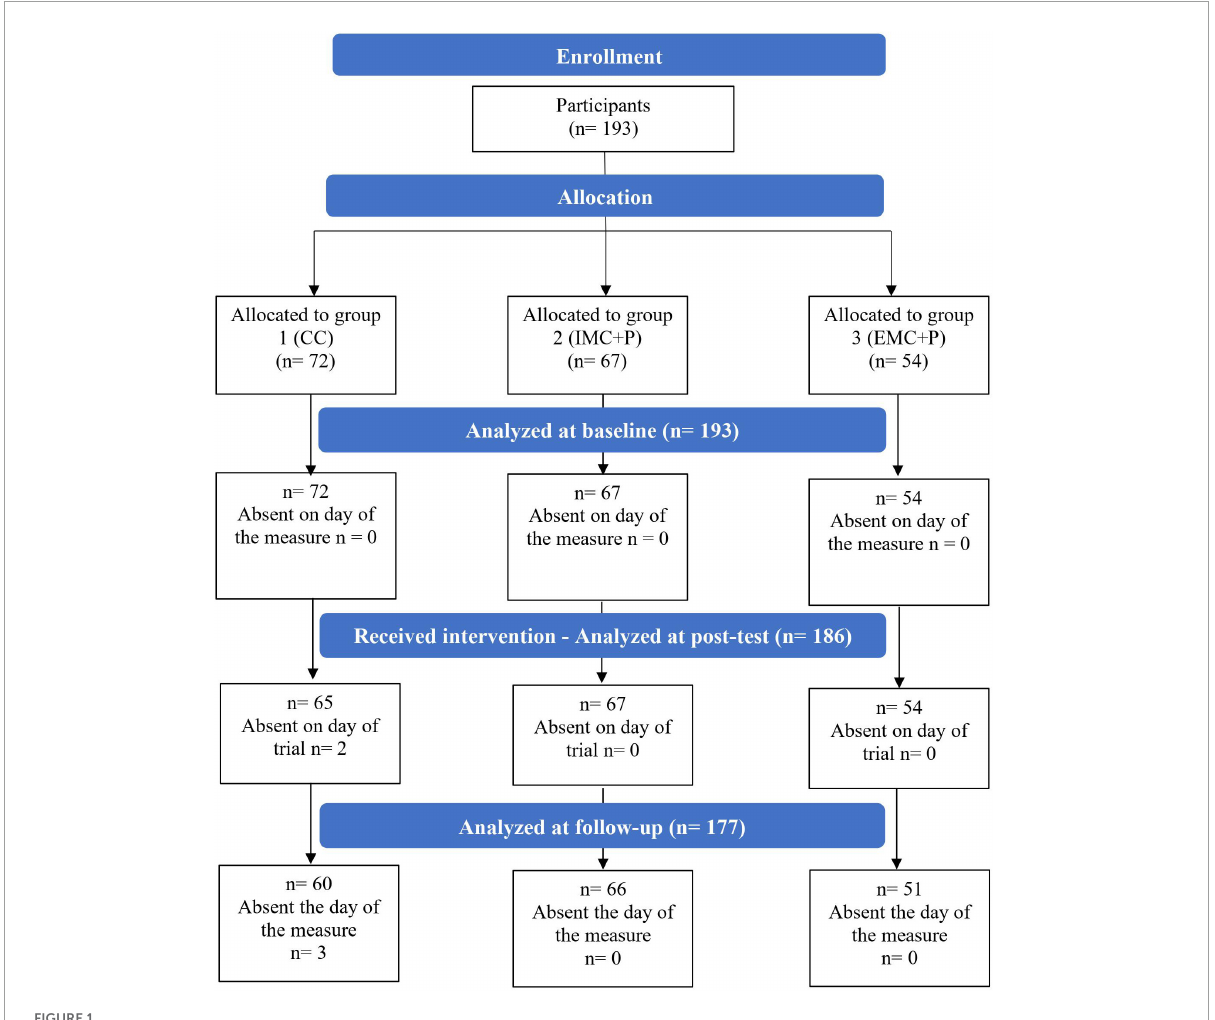
FIGURE1 Flow diagram of progress though the